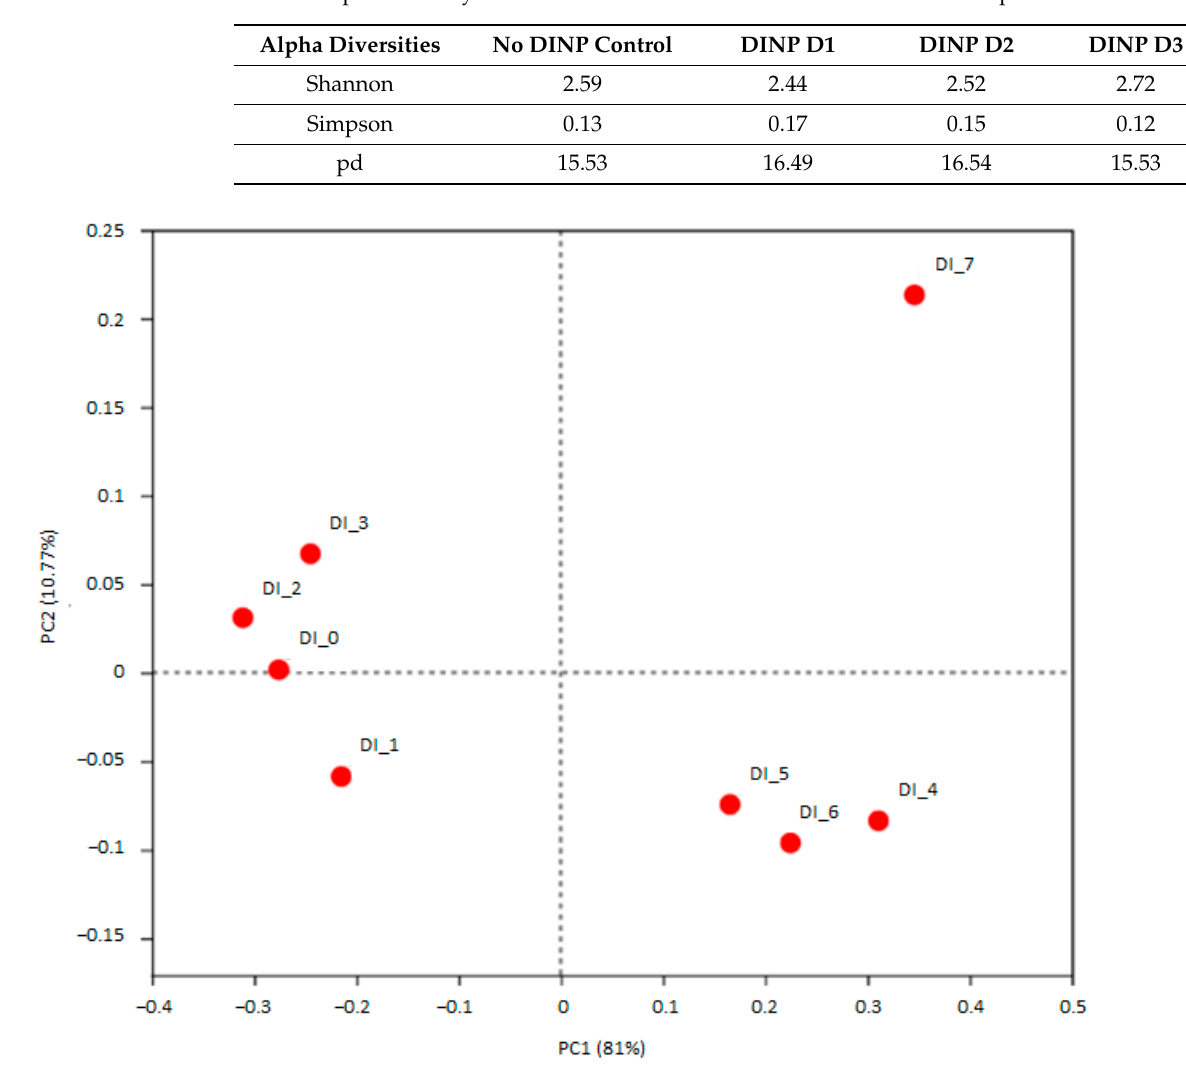
Figure 4. PCoA plot showing no DINP control, DINP-D1, DINP-D2 and DINP-D3 microbiota compositions at 0 h (DI_0 to DI_3) and 24 h (DI_4 to DI_7).